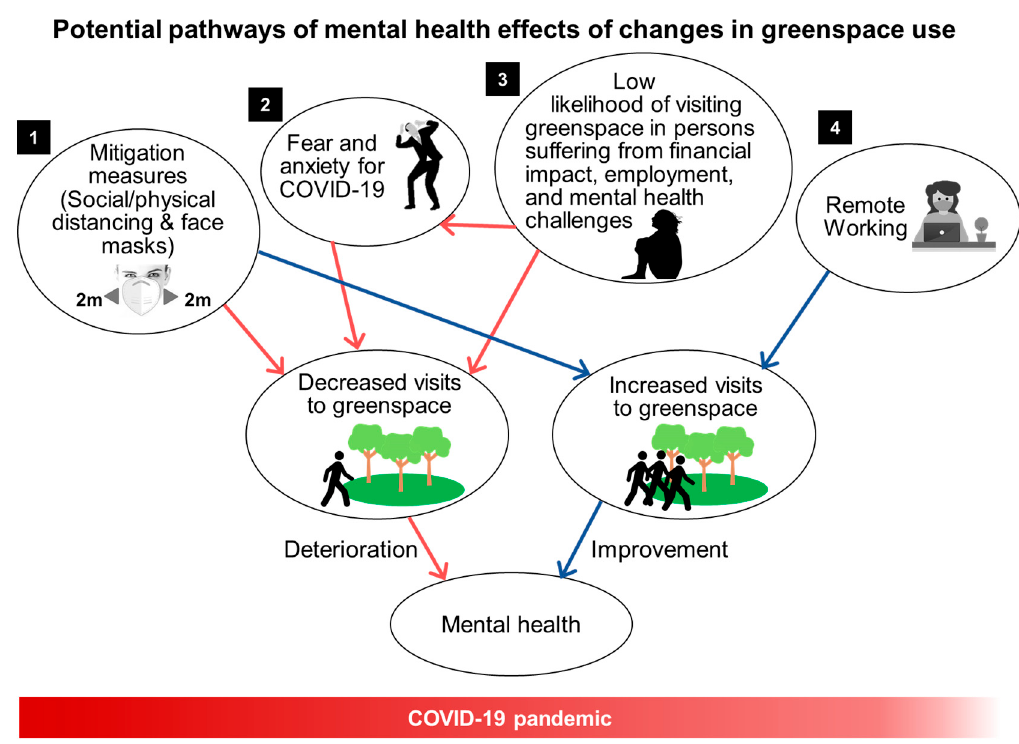
Figure 1. Pathways of changes in interactions with greenspace during the COVID-19 pandemic and their effects on mental health.